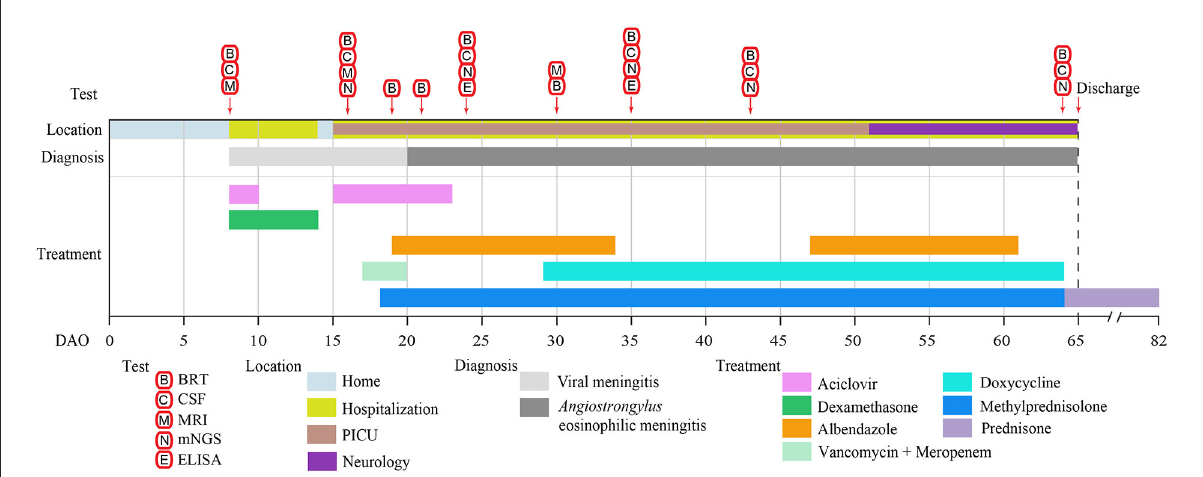
FIGURE1 The clinical test and treatment timeline of the patient. The location, diagnosis, treatment, and duration are represented by the colored bars. The clinical tests and their operating days are indicated by the arrows. BRT, blood routine test; CSF, cerebrospinal fluid; MRI, magnetic resonance